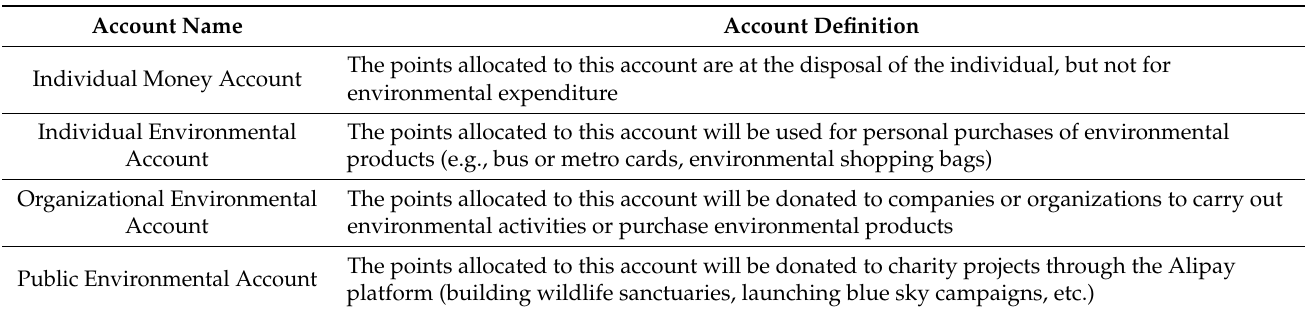
Table 3. Definitions of the four types of